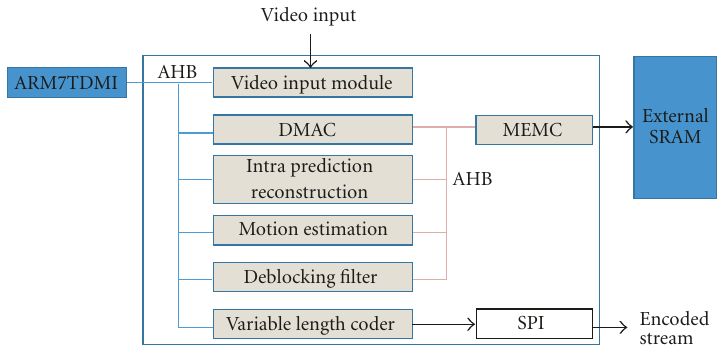
Figure 12: H.264/AVC encoder block